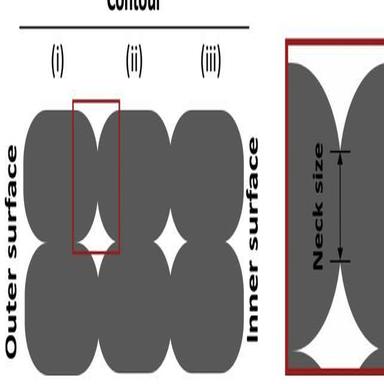
Illustration of the neck size measurement.